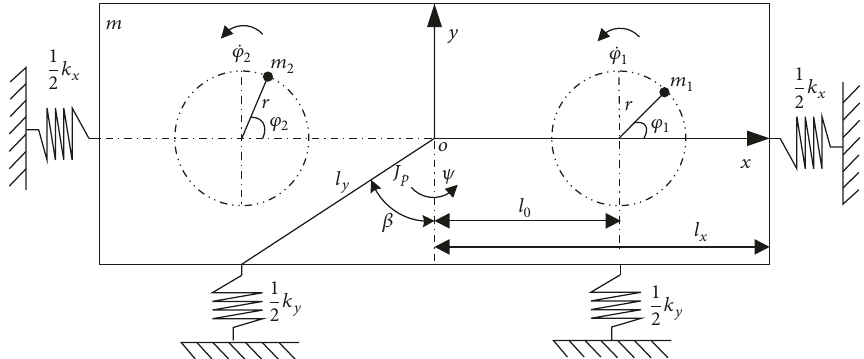
Figure 1: Dynamic model of the vibratory